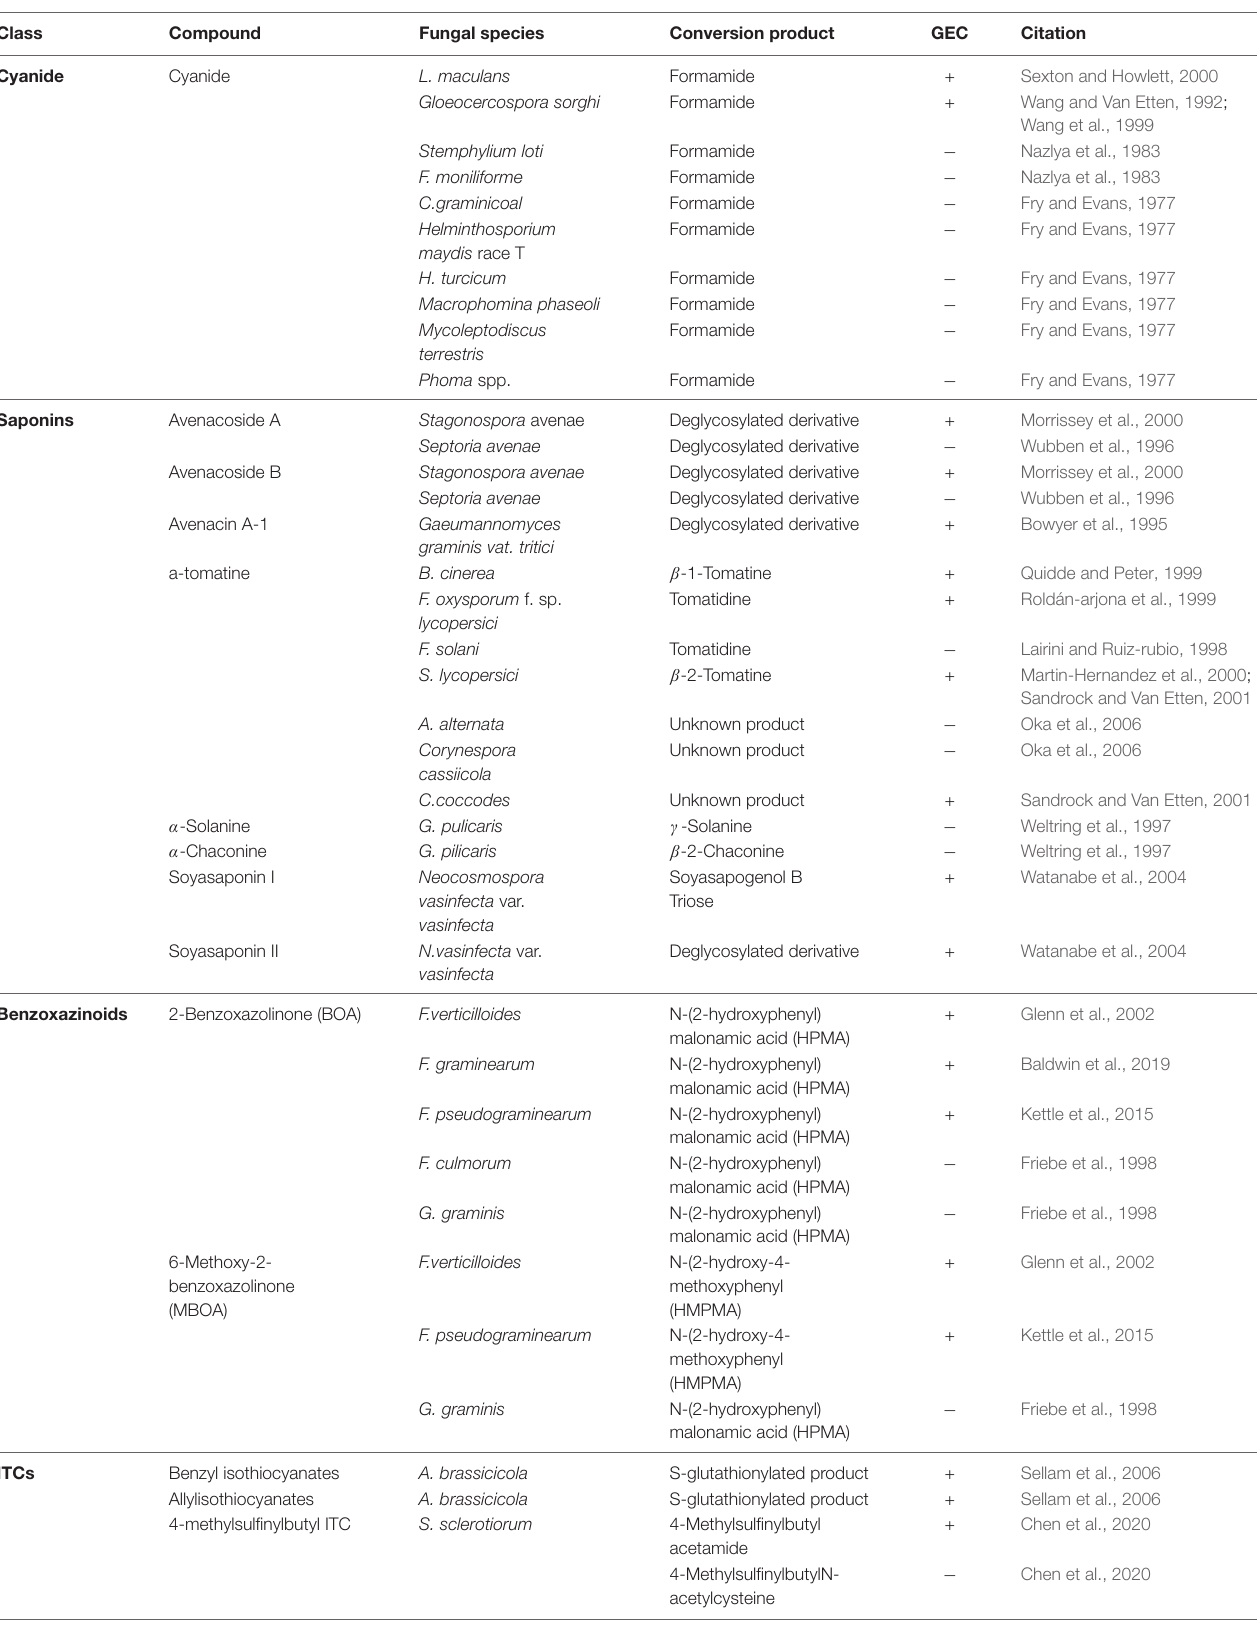
TABLE 3 | Metabolism of non-inducible PDCs by fungal necrotrophs and hemibiotrophs.